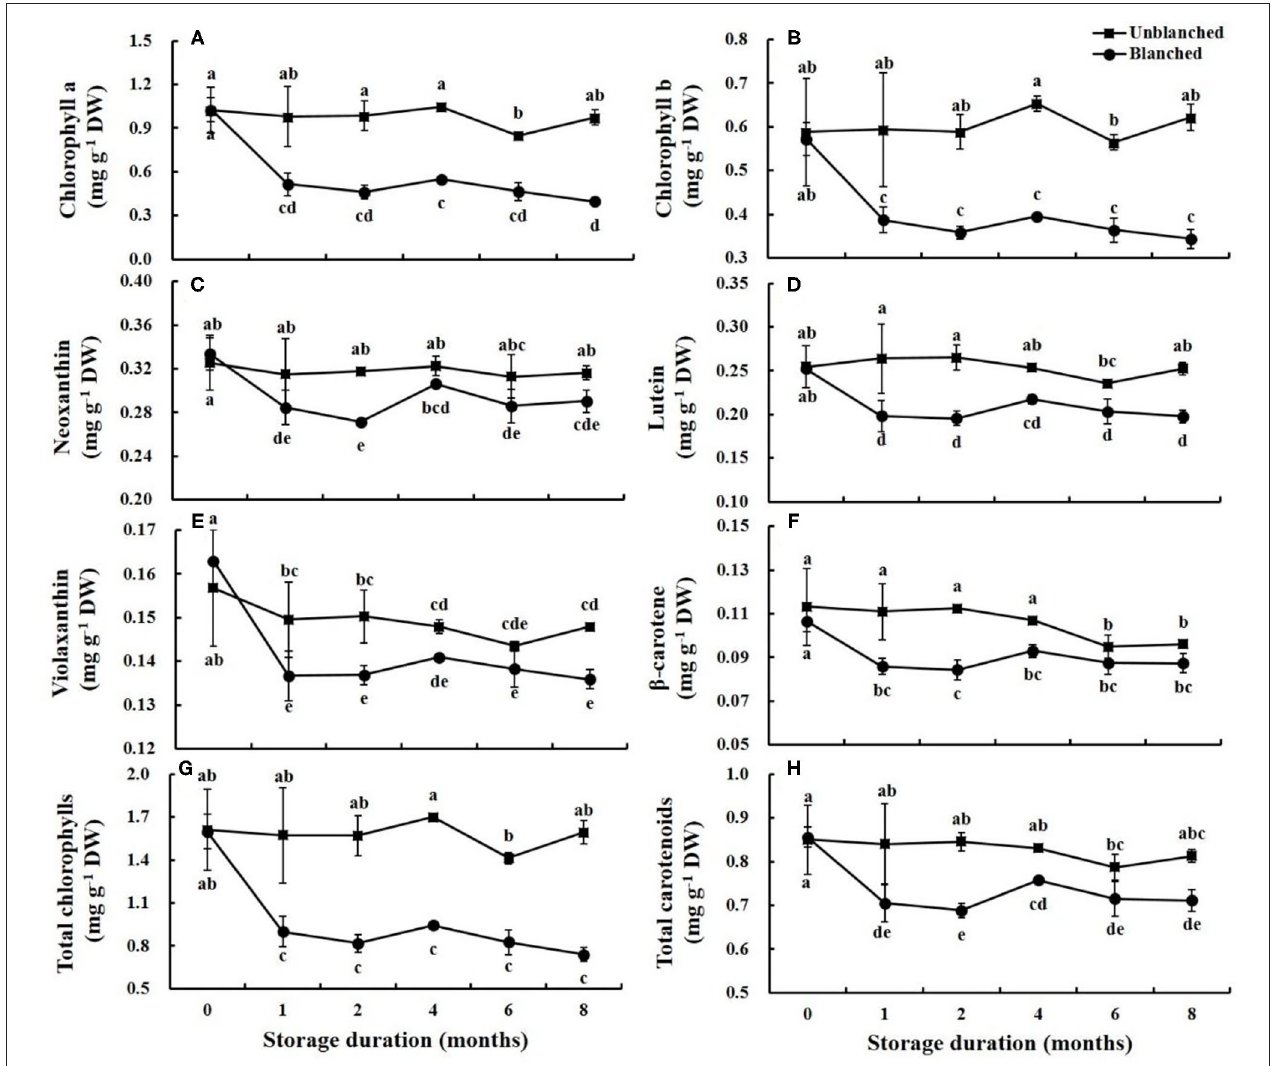
FIGURE 2 | Evolution trend of chlorophylls and carotenoids contents in baby mustard lateral buds during frozen storage at − 20 ◦ C. (A) chlorophyll a; (B) chlorophyll b; (C) neoxanthin; (D) lutein; (E) violaxanthin; (F) β -carotene; (G) total chlorophylls; H: total carotenoids. Unblanched represents no blanching before freezing; Blanched represents blanching before freezing. Values not sharing the same letter are significantly different at p <